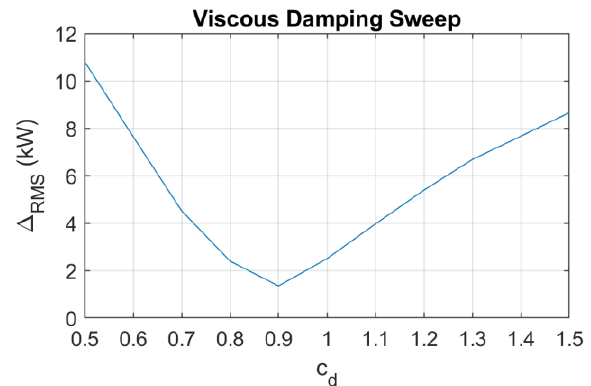
Fig. 7. Sweep of RMS difference between numerical and